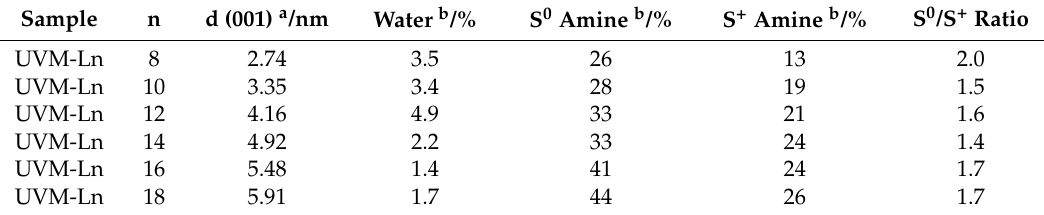
Table 1. Selected physical parameters for UVM-Ln pure silicas.